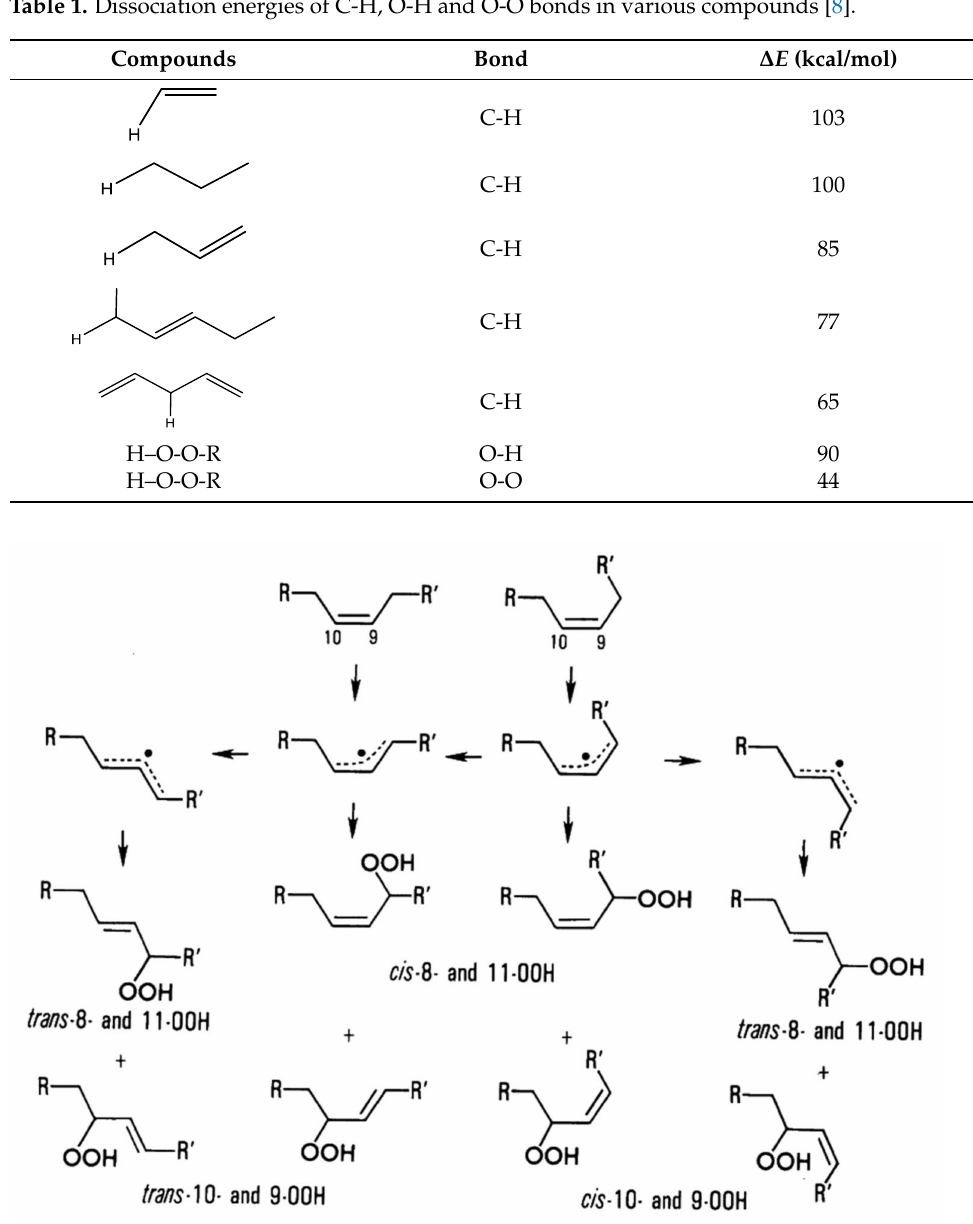
Figure 1. Mechanism of oleate oxidation. (R (cid:48) : (CH 2 ) 6 -COOH, R: (CH 2 ) 6 -CH 3 ). Adopted with permission from [10]. Copyright 2005, Elsevier Science; Woodhead